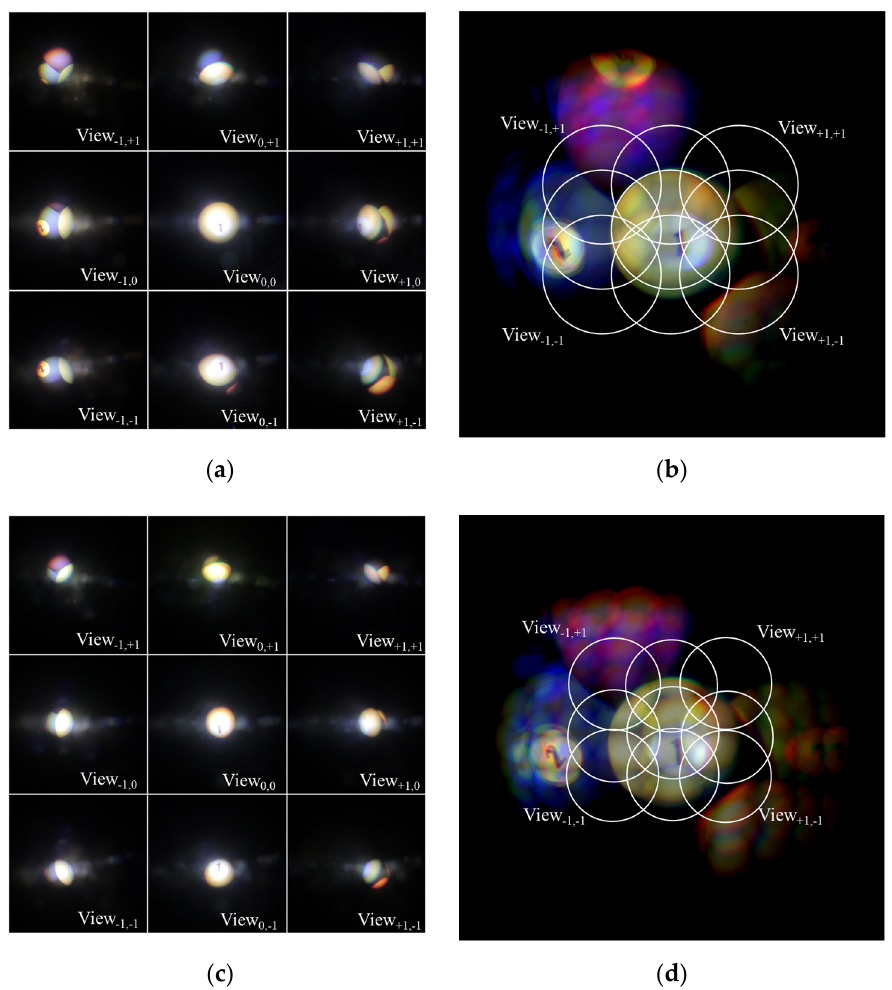
Figure 8. Captured views at two different eye positions. ( a ) The 3 by 3 of the captured views (9 by 9) at the fourth eye position 𝑒 (cid:2872) ; ( b ) integration from the views in ( a ); ( c ) the 3 by 3 of the captured views (9 by 9) at the fifth eye position 𝑒 (cid:2873) ; and ( d ) integration from the views in ( c ). The results of this experiment can be conveniently interpreted using WDF